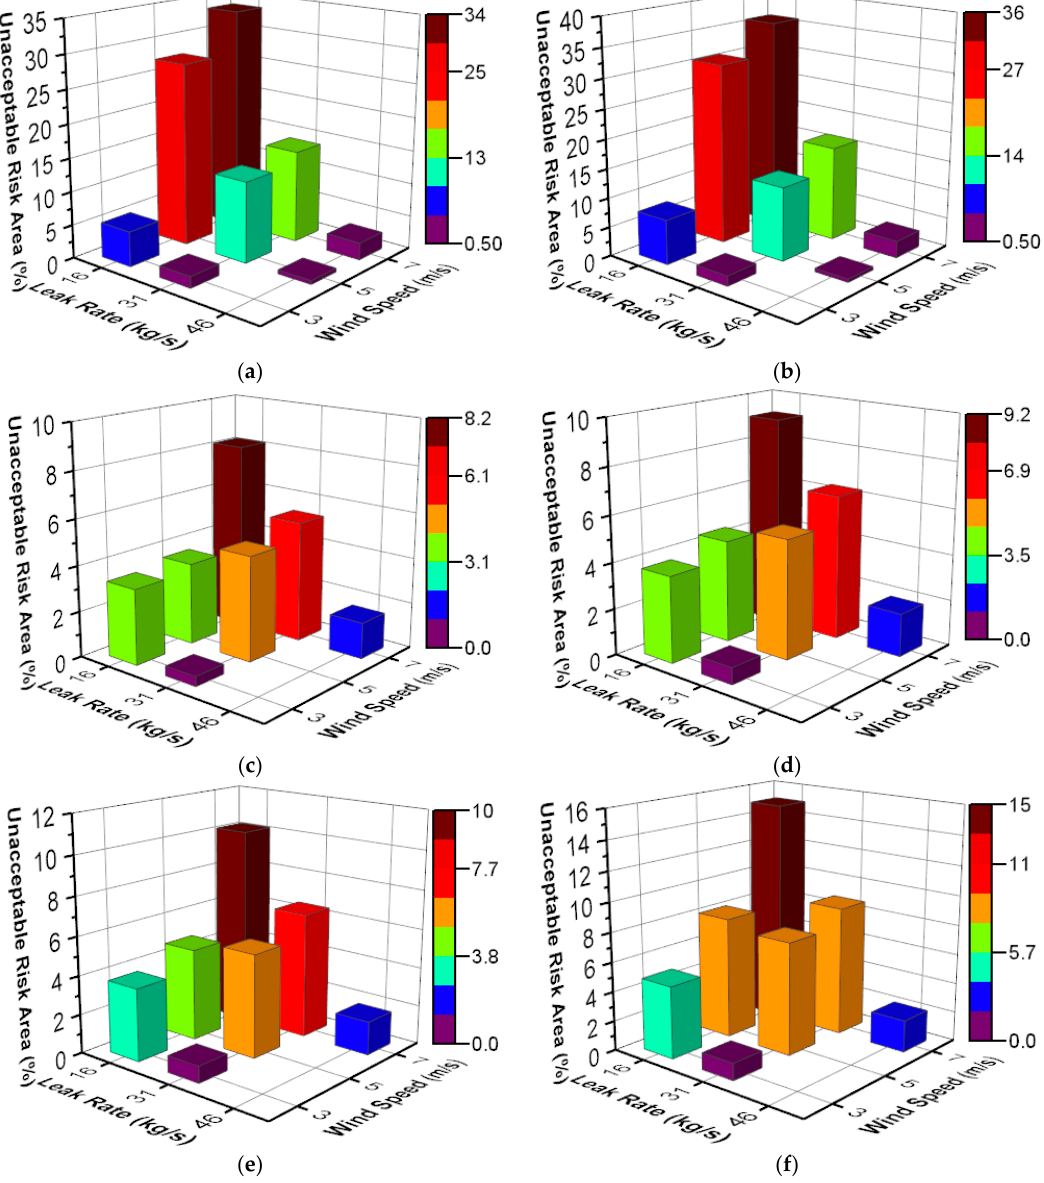
Figure 13. Unacceptable human fatality risk percentage area for leak direction RX+ at different years. ( a ) Head impact at year 3. ( b ) Head impact at year 5. ( c ) Lung damage at year 3. ( d ) Lung damage at year 5. ( e ) Whole-body displacement at year 3. ( f ) Whole-body displacement at year 5.